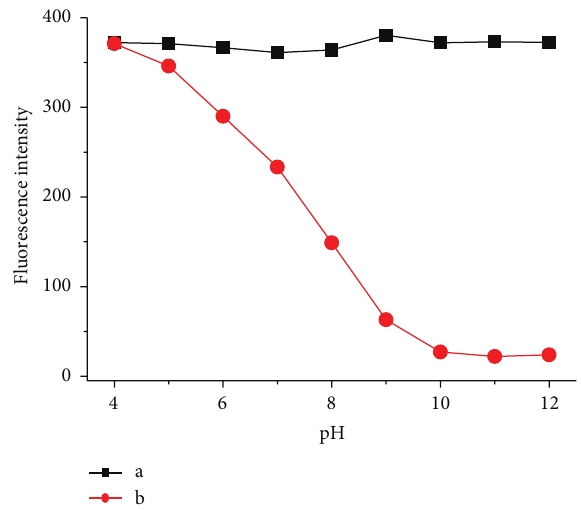
Figure 3: Fluorescence intensity of C -GGH at different pH: (a) free C -GGH, (b) C -GGH and Cu 2+ . Concentration of C -GGH is kept constant at 1.0 𝜇 mol/L. Concentration of Cu 2+ is 1.0 𝜇 mol/L. Excitation is selected at 430